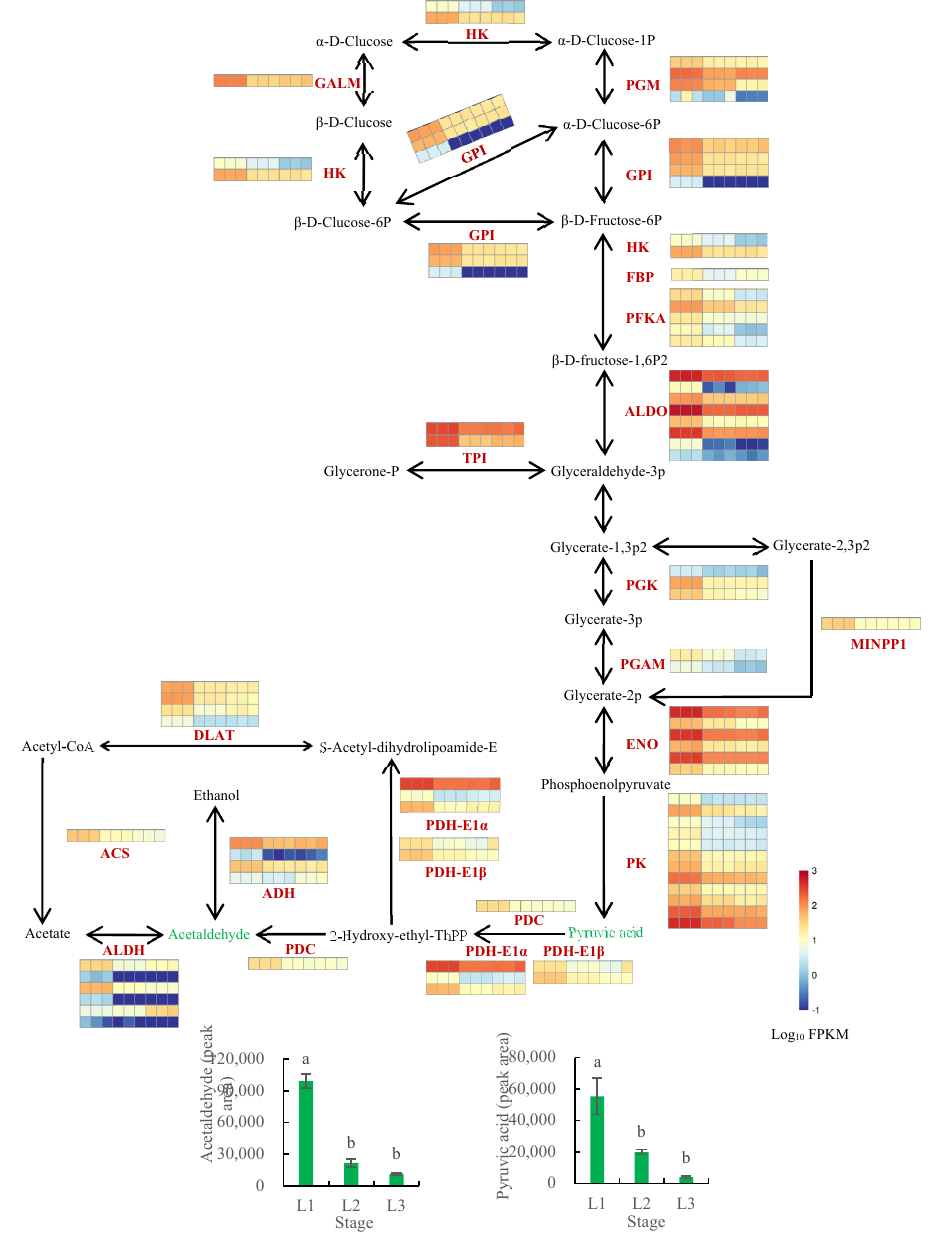
Figure 9. Analysis of the glycolysis biosynthesis pathway in walnut embryos. Note: the metabolite peak areas are shown in the cylindrical map, while the expression values of genes are in the thermal map, which shows the homogenization values of genes. The nine squares in each horizontal row correspond to the nine samples (L1_1, L1_2, L1_3, L2_1, L2_2, L2_3, L3_1, L3_2, and L3_3). L1 was 60 DAP, L2 was 90 DAP, and L3 was 120 DAP. Bars represent mean ± SE (n = 6). Bars with different lowercase letters (a and b) are significantly different ( p < 0.05). HK, hexokinase; PGM, phosphoglucomutase; GALM, aldose 1 − epimerase; GPI, glucose − 6 − phosphate isomerase; FBP, fructose − 1,6 − bisphosphatase; PCKA, phosphoenolpyruvate carboxykinase (ATP); ALDO, fructose- bisphosphate aldolase; TPI, triosephosphate isomerase; PGK, phosphoglycerate kinase; PGAM, 2,3 − bisphosphoglycerate − dependent phosphoglycerate mutase; ENO, enolase; PK, pyruvate kinase; MINPP1, multiple inositol polyphosphate phosphatase1; PDC, pyruvate decarboxylase; PDH − E1 α , pyruvate dehydrogenase E1 component alpha subunit; PDH − E1 β , pyruvate dehydrogenase E1 component beta subunit; ADH, alcohol dehydrogenase; ALDH, aldehyde dehydrogenase; ACS, acetyl − CoA synthetase; DLAT, pyruvate dehydrogenase E2